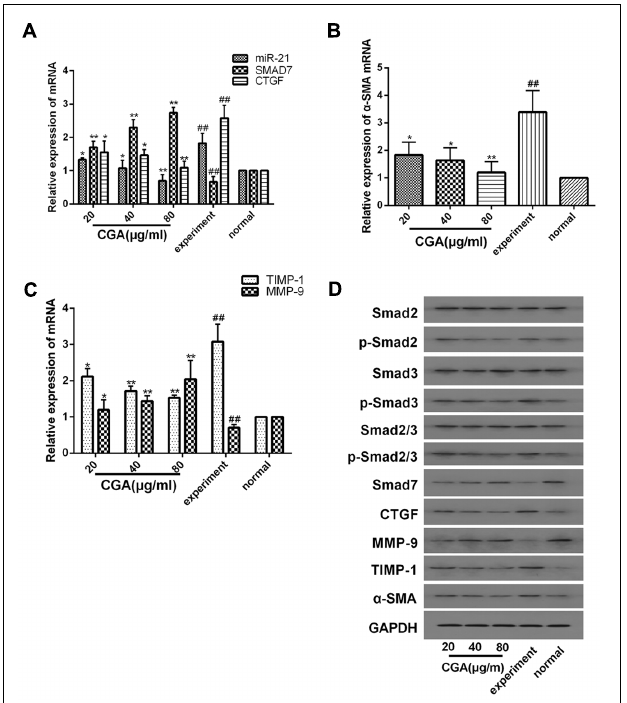
FIGURE 3 | Effects of CGA on the TGF- β 1/miR-21/Smad7 signaling pathway in LX2 cells after TGF- β 1 stimulation. (A–C) The mRNA levels were detected by real-time quantitative PCR. (D) The protein levels were assayed by western blotting. The data from three independent experiments are expressed as the means ± SD. ∗ P < 0.05 compared with the experimental group; ∗∗ P < 0.01 compared with experimental group; ## P < 0.01 compared with the normal group.